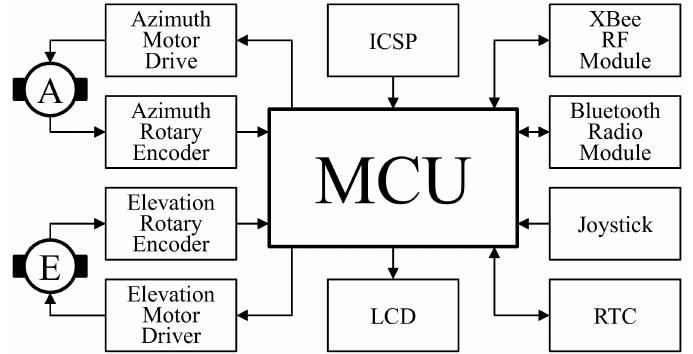
Figure 5. Block diagram of the remote terminal